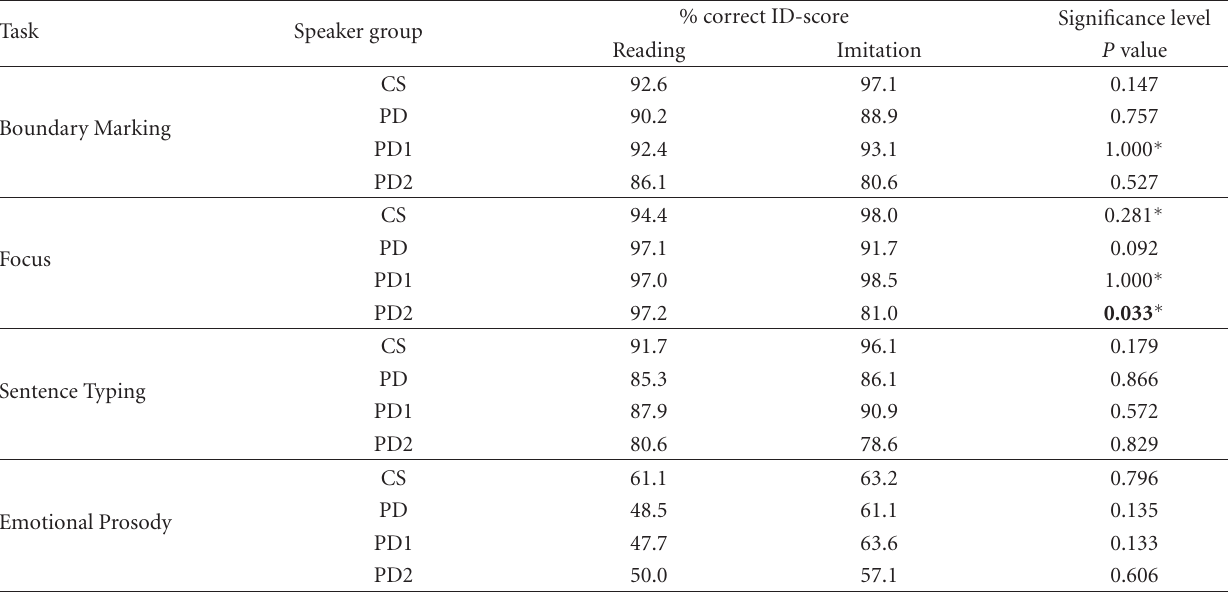
Table 6: Results for elicitation method: % correct identification scores and P values resulting from χ 2 test (statistically significant P values in bold